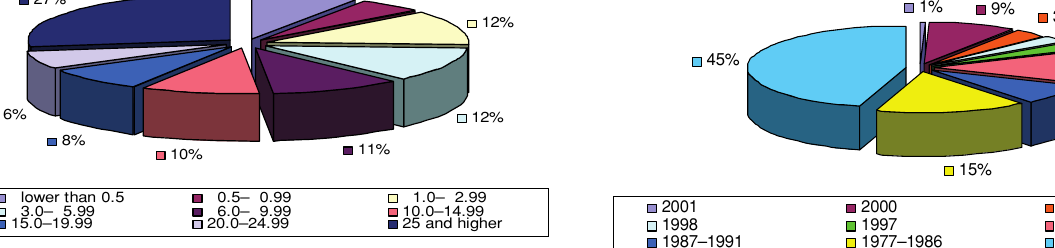
Figure 2: Distribution of apple orchards in the Northern Great Plain according to size